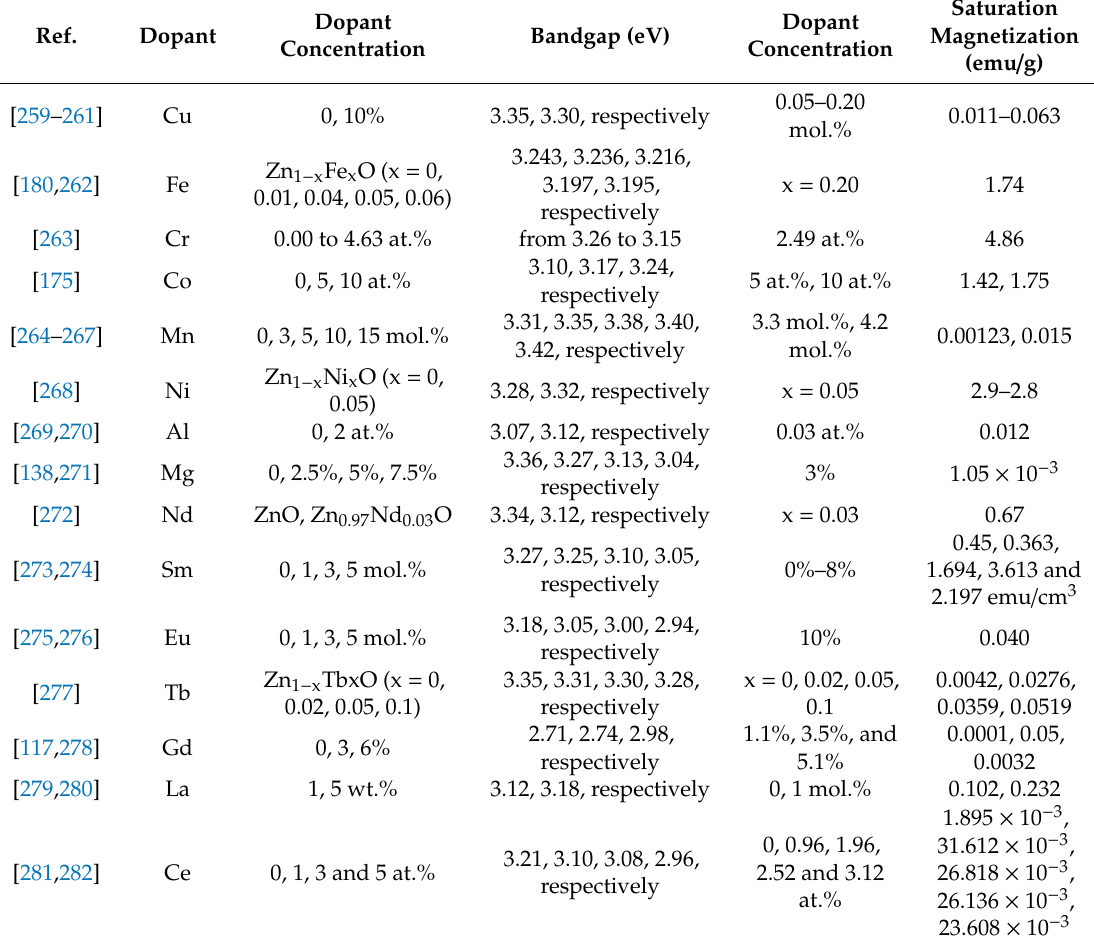
Table 3. Doped ZnO: optical and magnetic